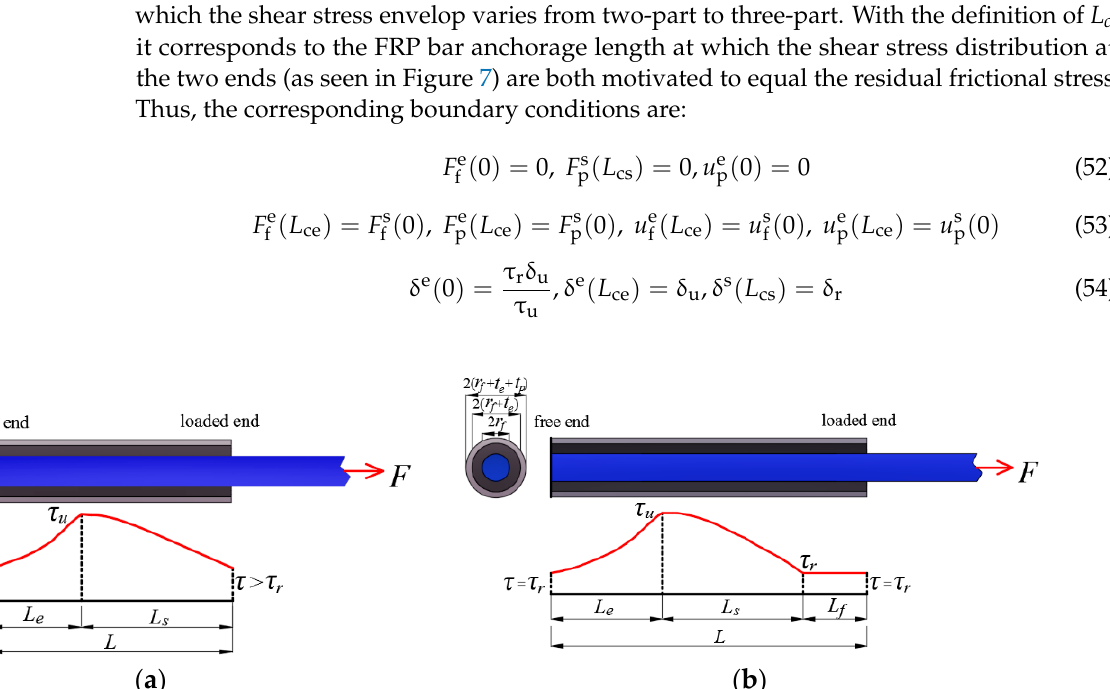
Figure 6. The shear stress envelop under the ultimate load transfer capacity:( a ) for L < L c ; ( b ) for L > L c .